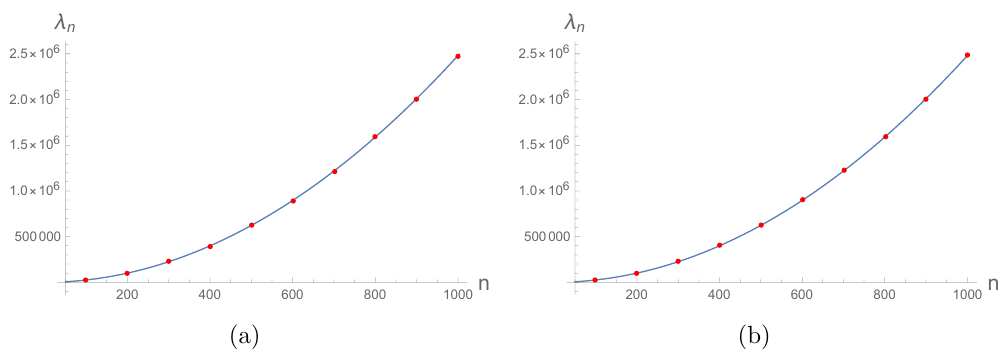
Figure 2. Asymptotic spectra generated by the potentials (3.55) for ˜ a ( z ) given by (3.54). The fitted data also include all eigenvalues with j ∈ [80 , 99] and j ∈ [901 , 999] , omitted in the plots. (a) mL = 1 / 2 . The result of the fit is Z 1 = 2 . 467401 , A 1 = 10 . 270160 , B 1 = − 3 . 737523 , C 1 = 39 . 926397 . (b) mL = 3 / 2 . The result of the fit is Z 2 = 2 . 467401 , A 2 = 12 . 934720 , B 2 = 6 . 267183 , C 2 = 36 . 382785